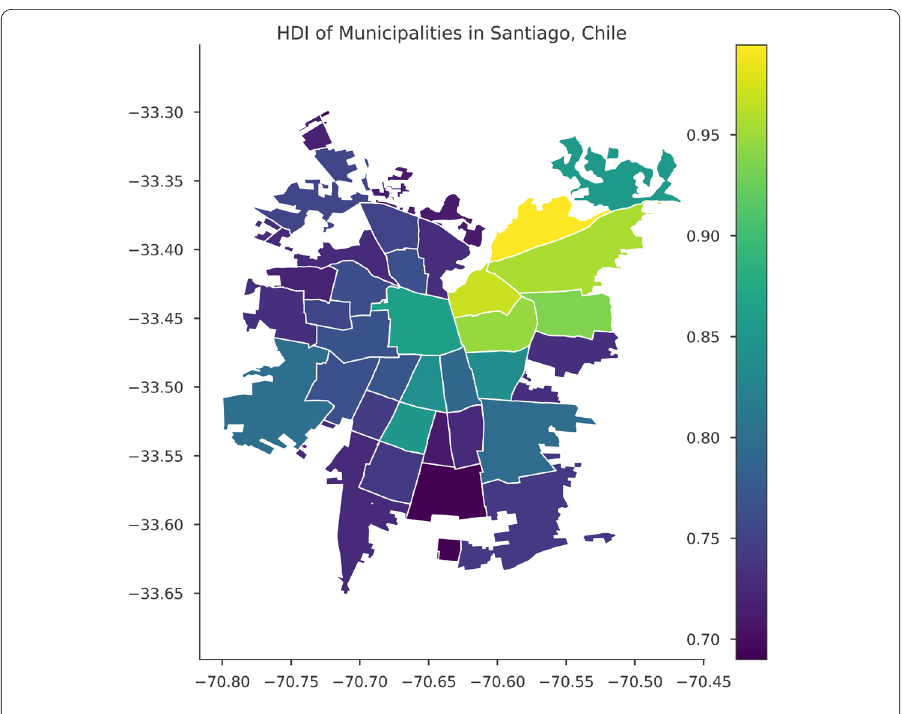
Figure 4 Choropleth map of Santiago. The color scale represents the estimated Human Development Index (HDI) of each comuna within the city